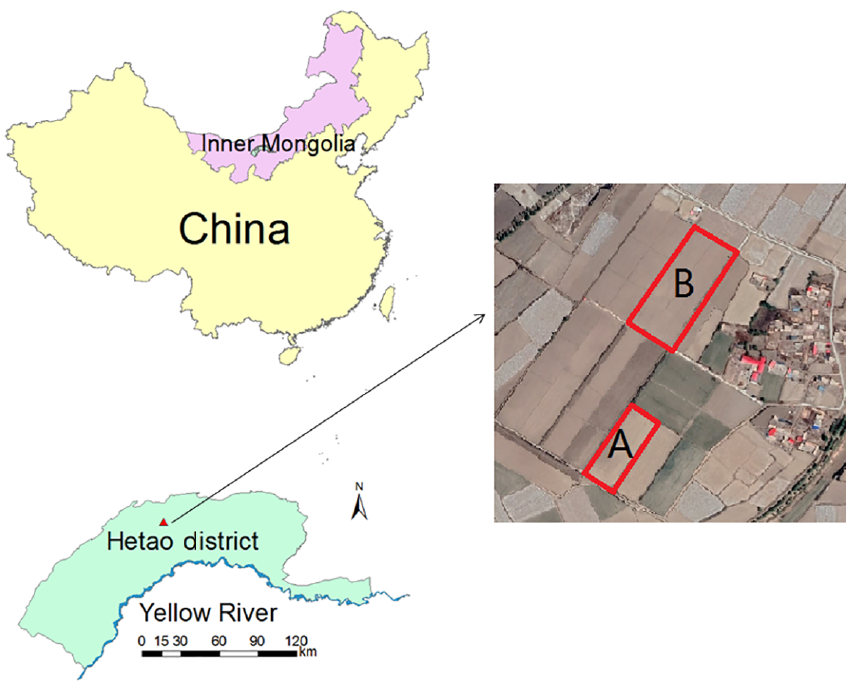
Figure 1. Location of the field experiment in Hetao irrigation district. The blue line is the Yellow River. Table 1. Crop growth stage in 2016 and 2017 for corn growth on the Fenzidi experimental fields in the Hetao district. Year or growth Seeding Jointing Heading